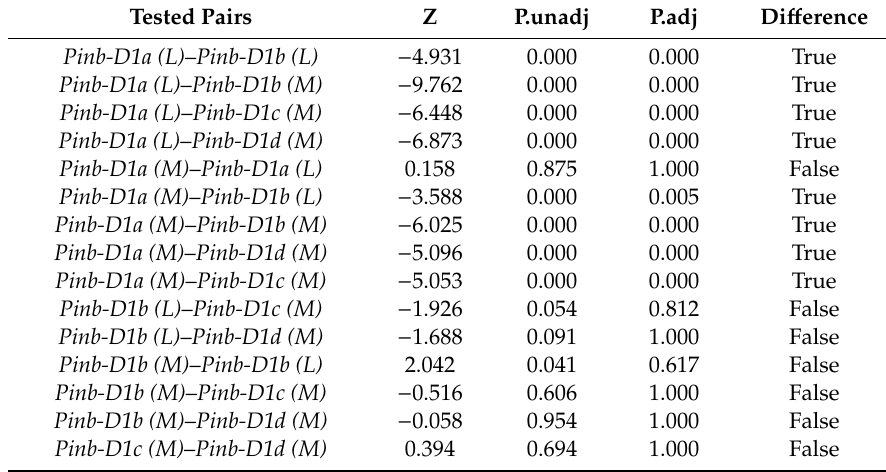
Table 2. Dunn test for multiple comparisons of SKCS hardness in six allele groups. (L)—landraces, (M)—modern cultivars and breeding